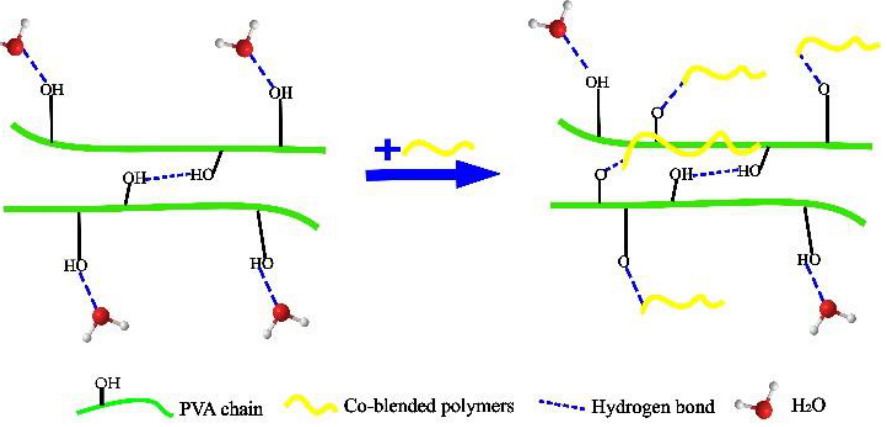
Figure 4. Diagram of polymer co-blend modification.